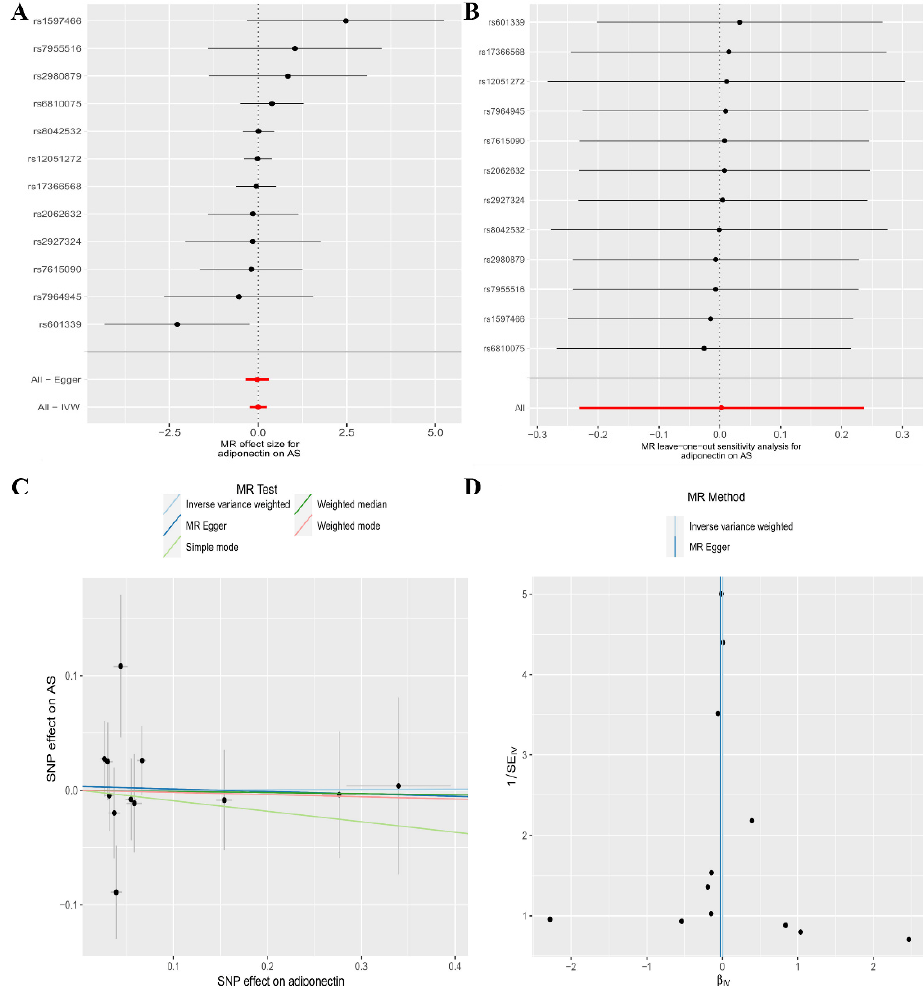
Figure 2. The association between circulating adiponectin levels and the risk of ankylosing spondylitis is presented in ( A ) a forest plot, ( B ) a leave-one-out sensitivity analysis, ( C ) a scatter plot, and ( D ) a funnel plot. Table 3. Detailed statistics of selected instrumental variables for ankylosing spondylitis and their relationship with circulating adiponectin